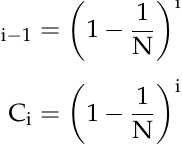
Table 1. Effect on the average concentration of dissolved solids (or particles) by removing water from a pool one container- full at a time and replacing the water removed with the same quantity of pure water, thereby progressively diluting the water in the pool. Cumulative Fraction of Pool State Volume Removed Starting state After first container After second